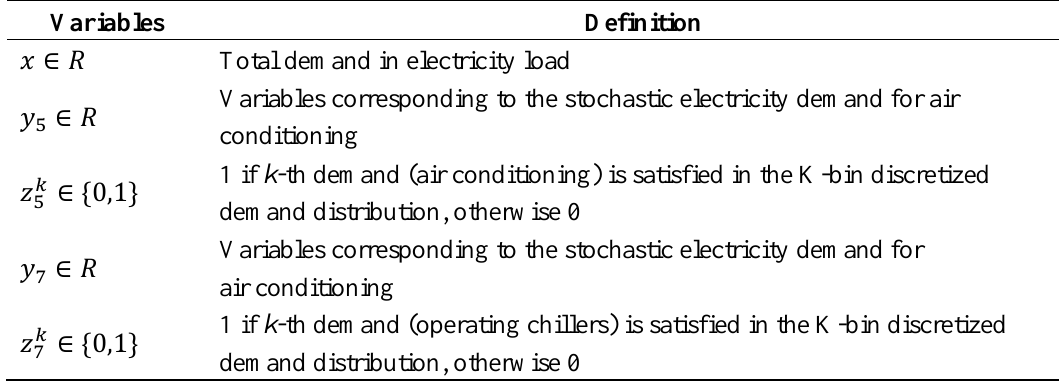
Table 4. Definition of variables in the model.